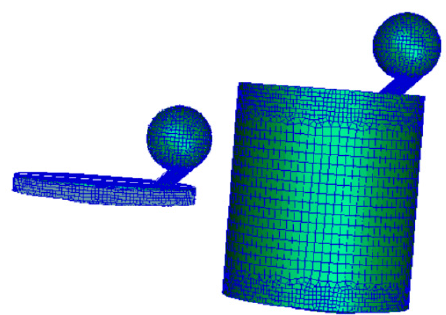
Figure 3. Engine computational grid in Top Dead Centre ( TDC) and Bottom Dead Centre (BDC) positions.